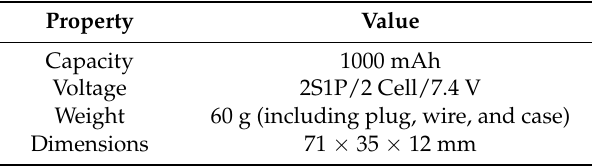
Table 1. Specifications of Nanotech 1.0 Battery